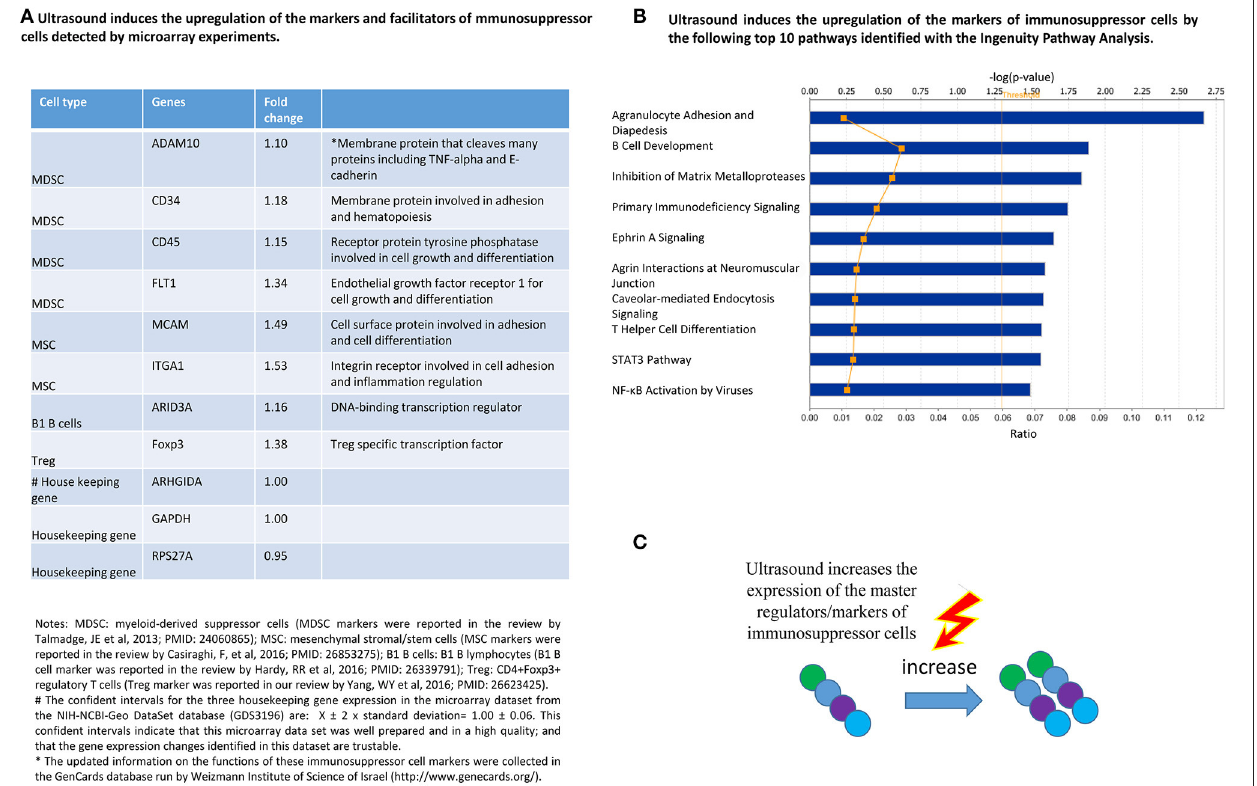
FIGURE 3 | LIUS therapy increases the expression of immunosuppressive cell markers/regulators. (A) The list of regulators of immunosuppressive cells that showed increased expression when subjected to LIUS. (B) The major signaling pathways that are affected by the regulators of immunosuppressive cells identified in our analysis. (C) Graphical representation of our conclusion that LIUS may increase the expression of markers/regulators of immunosuppressive cells.